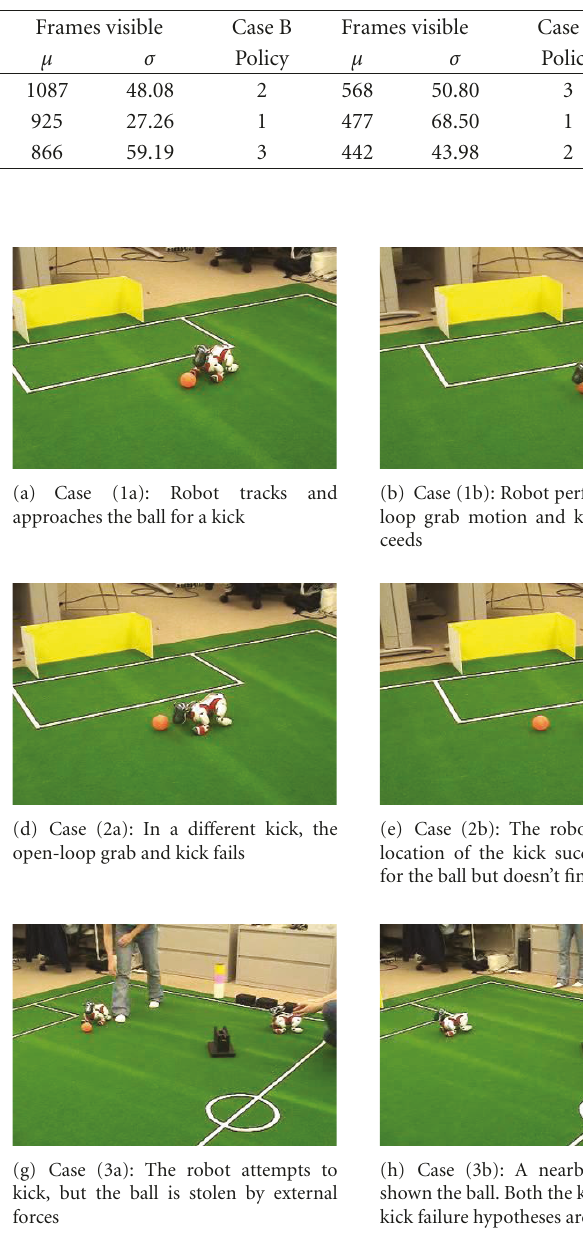
Figure 7: An illustrative example of the prioritized multiple hypothesis algorithm for reasoning about possible locations for the ball.